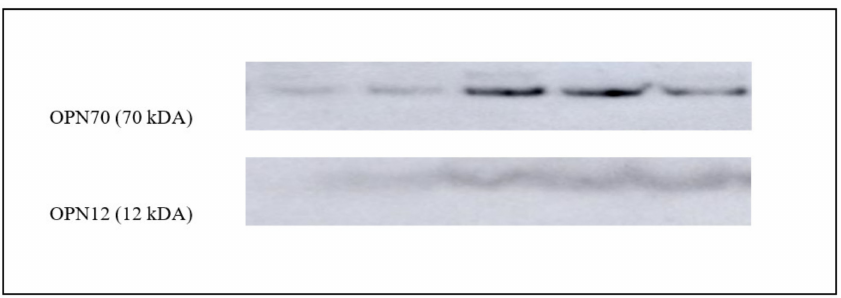
Figure 2. Indicative band patterns of seminal plasma OPN. Two reactive areas were located at 70 kDa and 12 kDa.